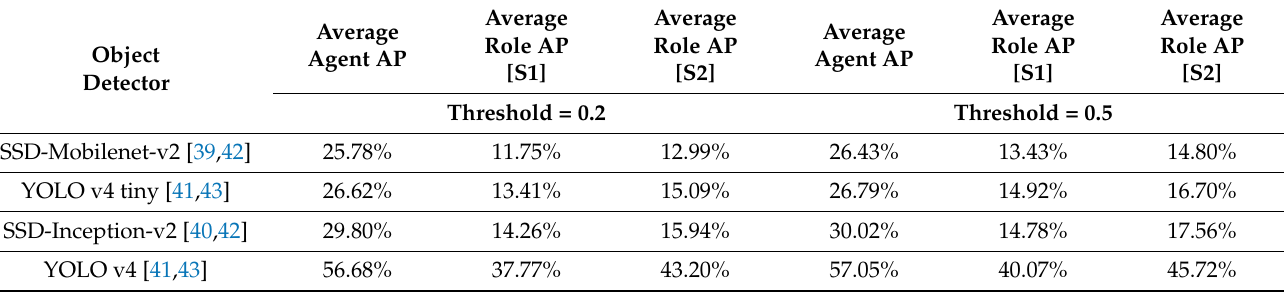
Table 4. HOI detection evaluation for agent and